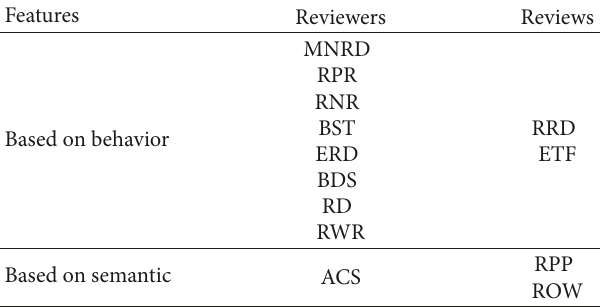
Table 2: Features extraction in different